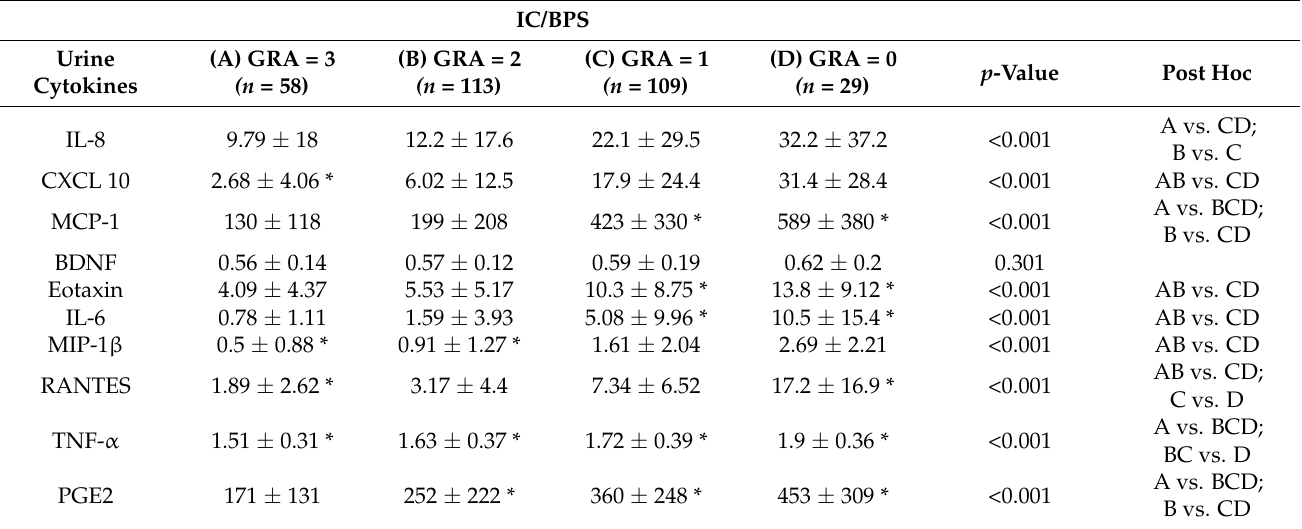
Table 6. Association between urinary biomarker levels and global response assessment after the treatment of patients with interstitial cystitis/bladder pain